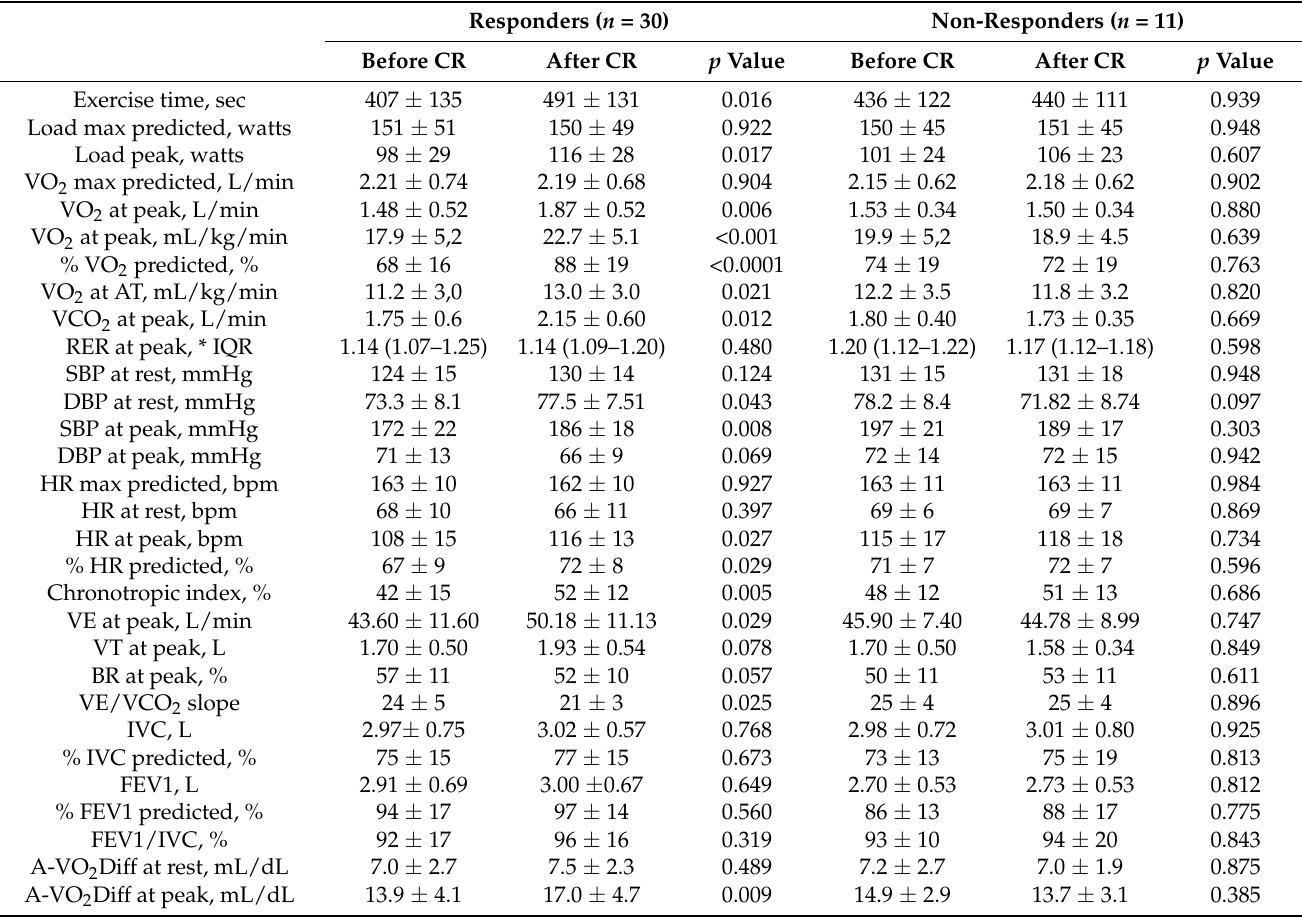
Table 2. Cardiopulmonary exercise testing parameters during CPET-SE before and after cardiac rehabilitation. Responders ( n = 30) Non-Responders ( n = 11)